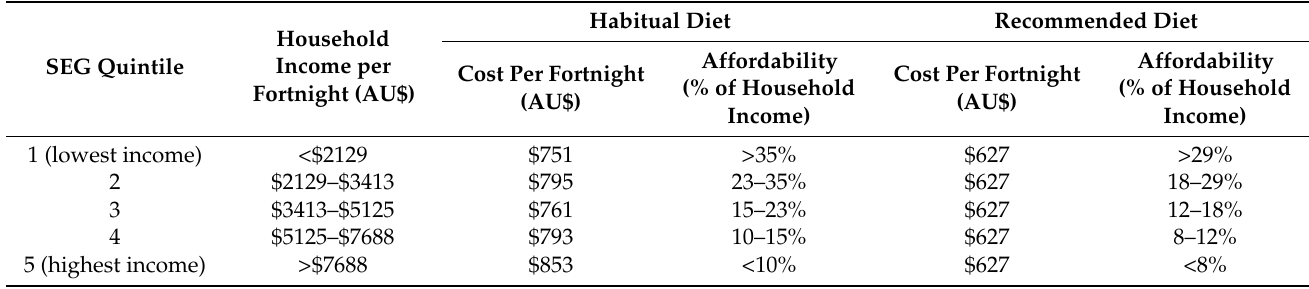
Table 3. Gross household income, habitual and recommended diet cost, and affordability per fortnight in each SEG for a reference